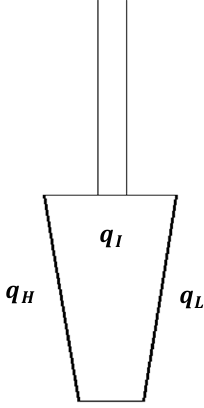
Figure 2. Fundamental sector of a simplified bladed disk.